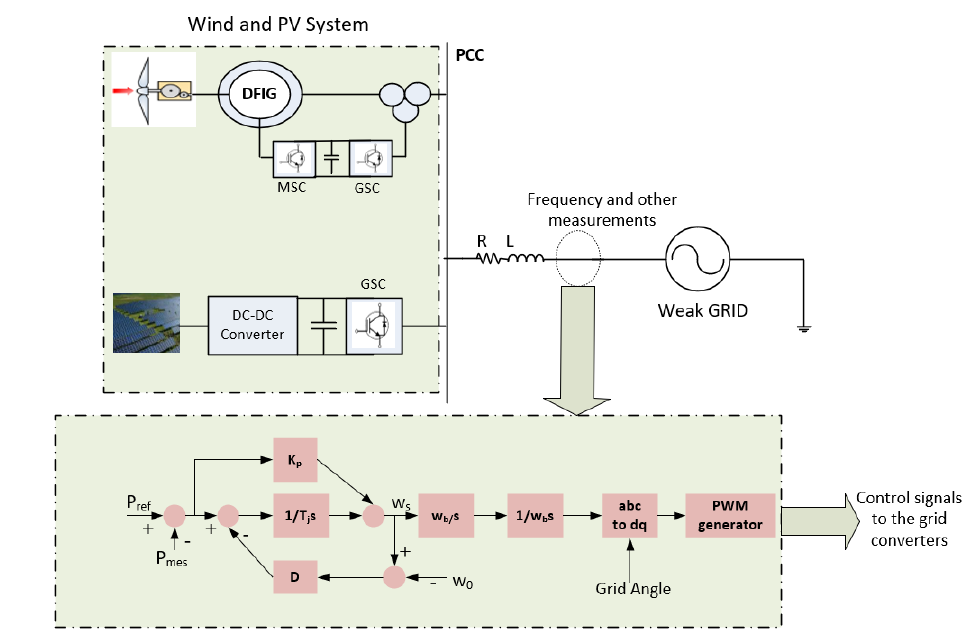
Figure 14. Grid-forming control technique for weak